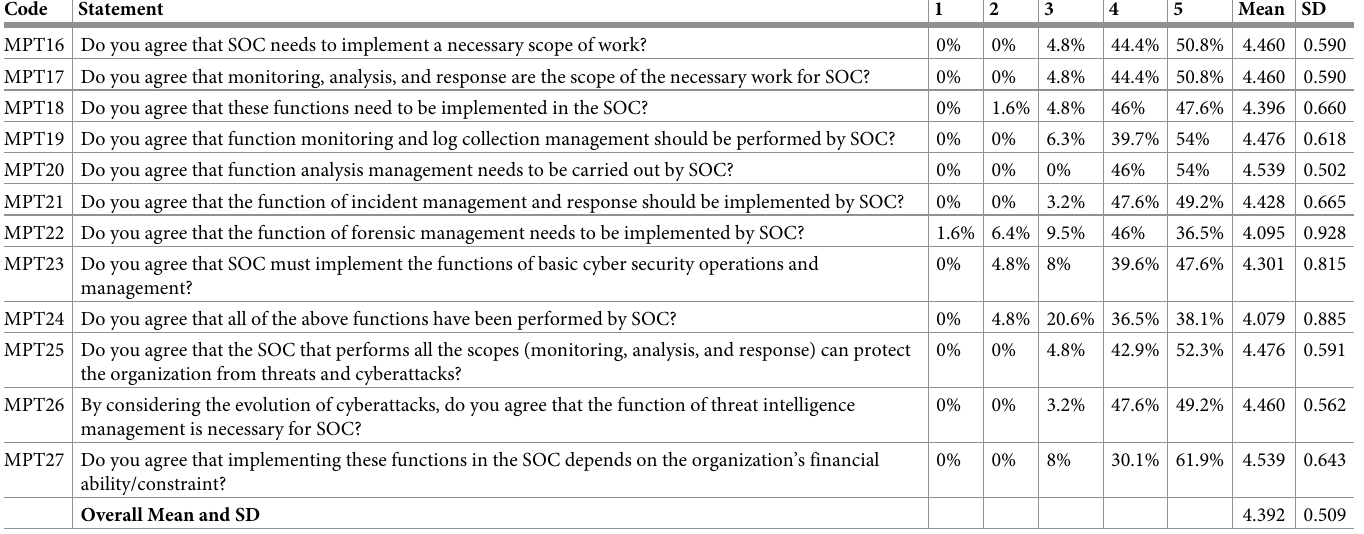
Table 14. Questionnaire results for technology